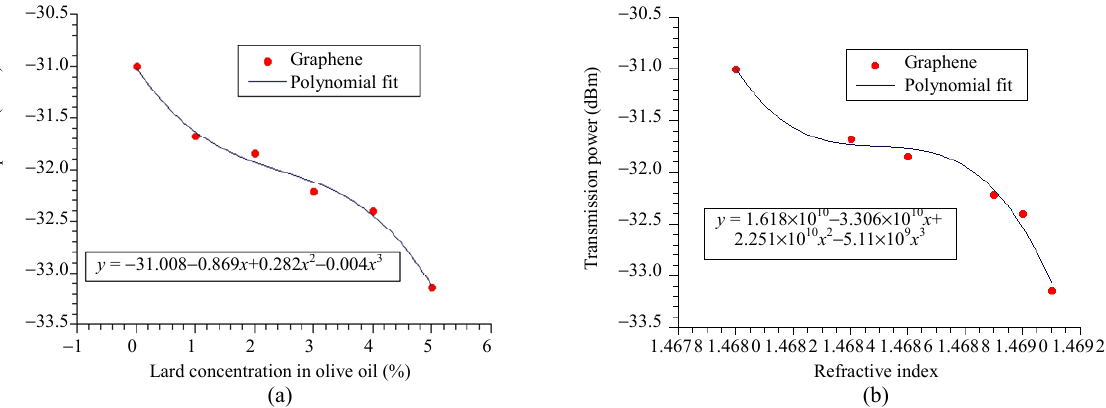
Fig. 5 Transmission power of the graphene-coated tapered POF as a function of (a) lard concentration in olive oil and (b) refractive